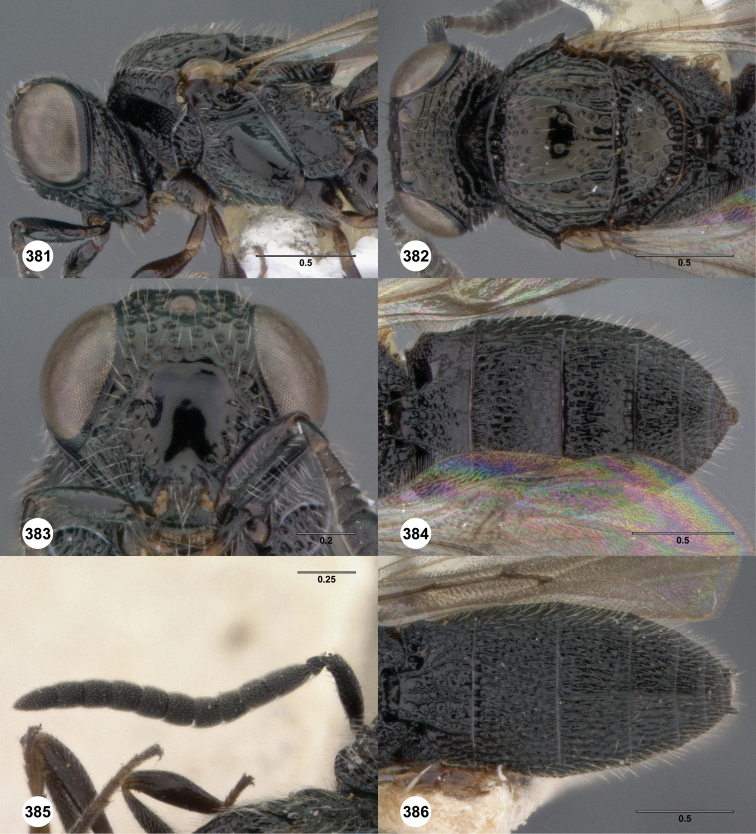
Oxyscelio uncinorum sp. n., paratype female (OSUC 462590) 381 Head and mesosoma, lateral view 382 Head and mesosoma, dorsal view 383 Head, anterior view 384 Metasoma, dorsal view. Paratype male (OSUC 359611) 385 Antenna 386 Metasoma, dorsal view. Morphbank100